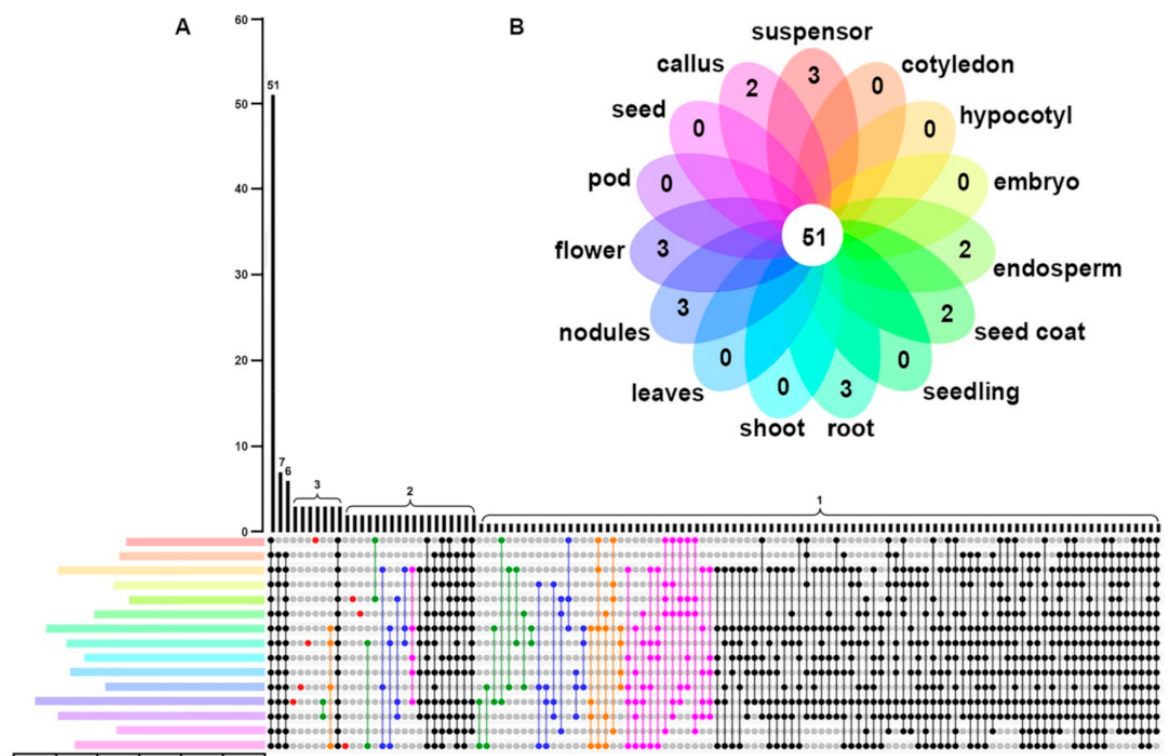
Figure 8. Distribution of tissue-independent and tissue-specific genes in soybean. ( A ) The UpSet plot depicts how many GmABCs are expressed in each tissue (suspensor, cotyledon, hypocotyls, embryo, endosperm, seed coat, seedling, root, shoot, leaves, nodule, flower, pod, seed, and callus). Each color represents a tissue, and its length refers to the number of expressed genes. The black dots indicate the number of genes expressed in each tissue. The only dot (red) represents the number of genes unique to this tissue, and two or more dots connected by a line represent the number of genes expressed in several tissues. The green, blue, golden yellow, and pink lines connecting the dots represent the number of genes expressed in two, three, four, and five tissues, respectively. The dark line represents the number of genes expressed in at least six tissues. ( B ) The Venn diagram shows the specific expressed GmABCs in different tissues of